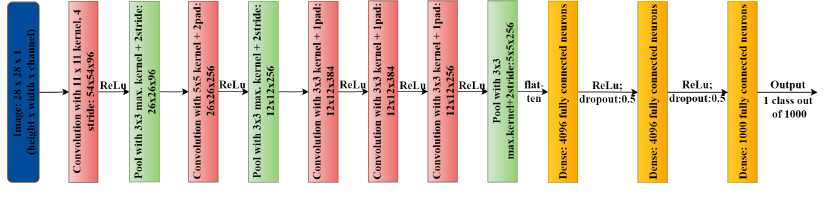
Figure 3. AlexNet